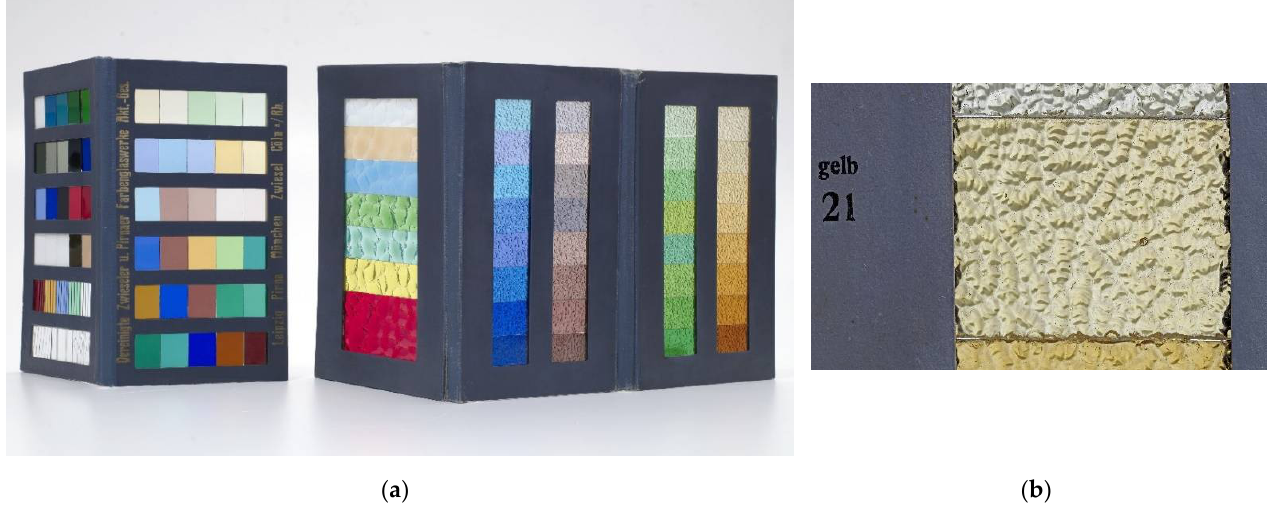
Figure 17. Template of the former glass manufacturer: ( a ) a whole range of colors and ( b ) ornamental glass in a yellowish color used during the renovation of Centennial Hall, in accordance with the original documentation.